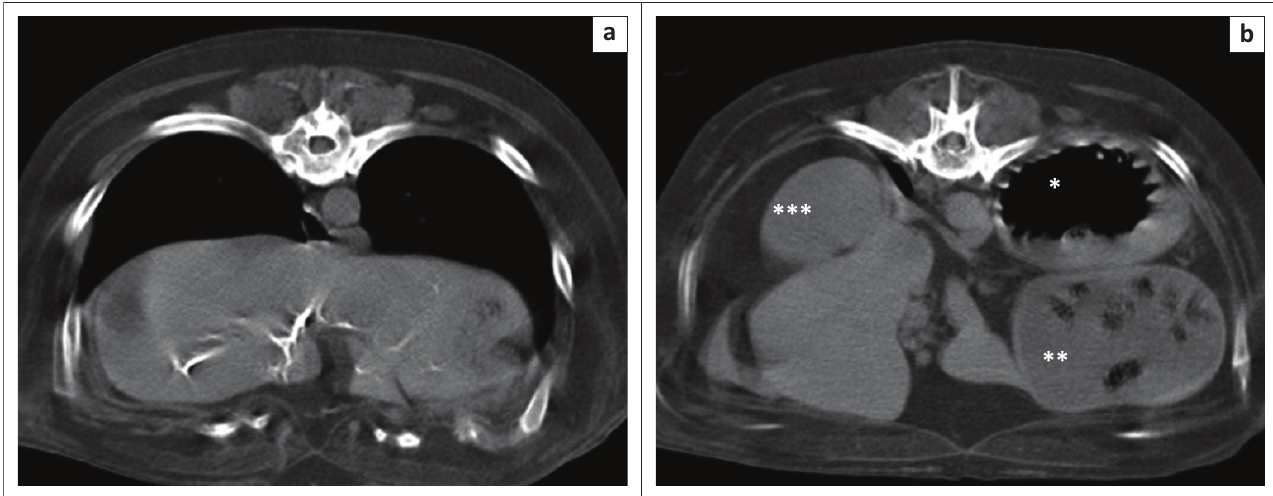
FIGURE 2: Transverse computed tomography images of the abdomen (a) at level of liver and (b) at level of stomach. Note the arborising hyperattenuating mineralised tracts, mainly in the right liver lobes in (a). In (b) the gas-filled corpus ( * ) is seen dorsally to the food-filled pyloric antrum ( ** ) in the left abdomen. The kidney ( *** ) is seen on the right side. Images are all in a soft tissue window (window width 600 HU and window level 40 HU). Left is to the right of the images. Some motion blur is